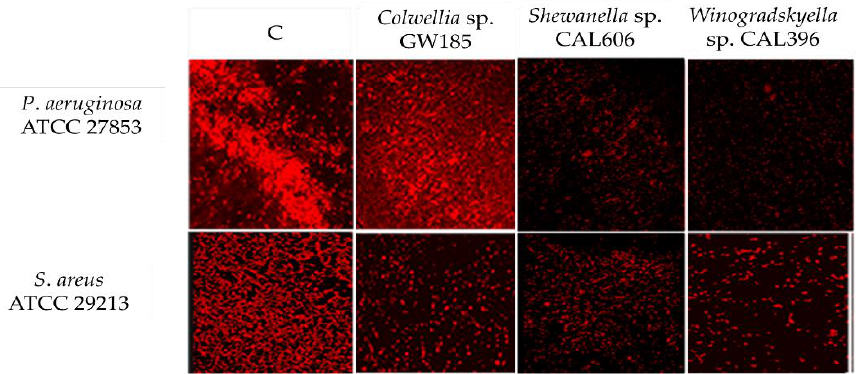
Figure 4. Confocal laser images ( × 400) of biofilm formed by P. aeruginosa ATCC 27853 and S. aureus ATCC 29213 in the absence (Control, C) or in the presence of crude extracts (400 µ g/mL) from Colwellia sp. GW185, Shewanella sp. CAL606 and Winogradskyella sp. CAL396 after 24 h ( S. aureus ) or 48 h ( P. aeruginosa ) treatment.